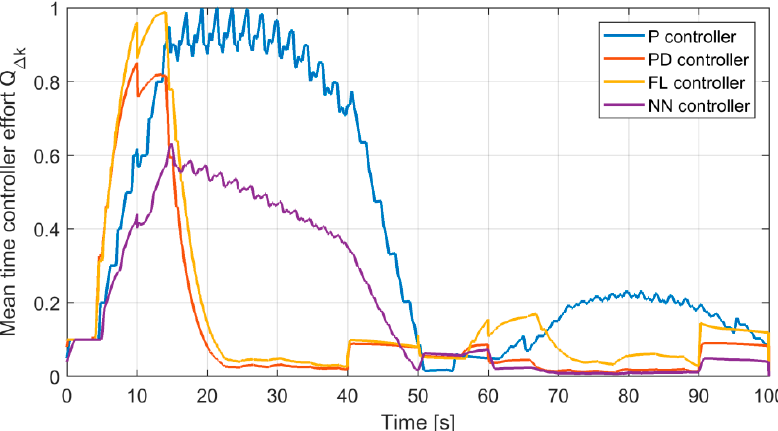
Figure 16. The comparison of the mean time effort of the four investigated controllers (∆𝑇 = 10 s) .